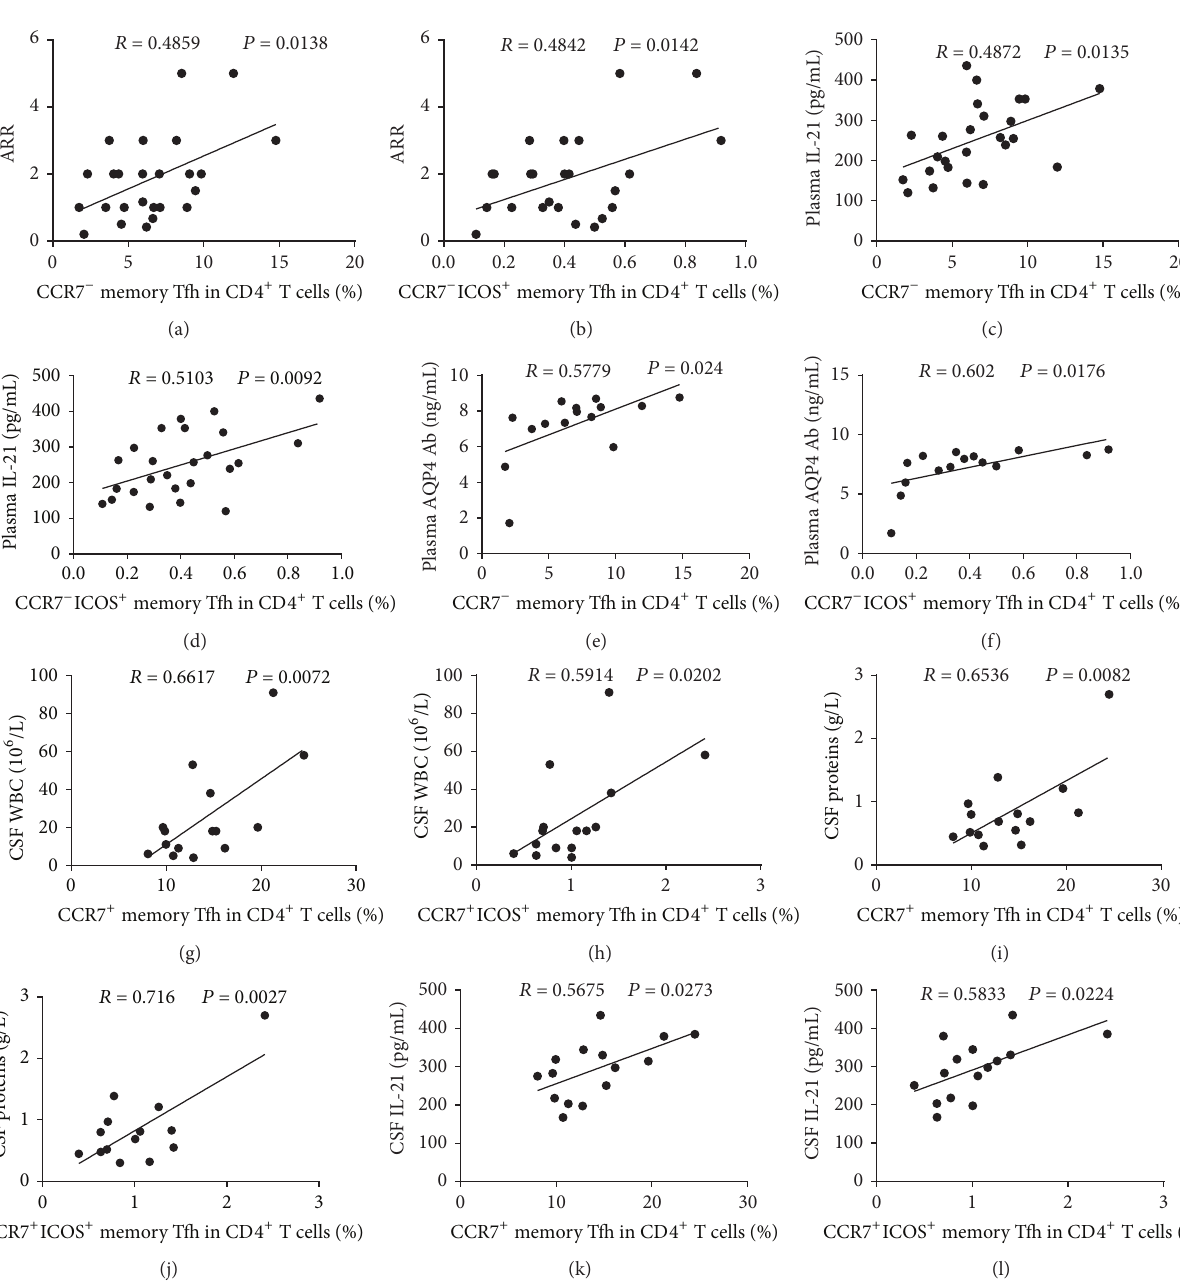
Figure 6: Correlation analysis of different subsets of circulating memory Tfh cells with the values of clinical measures in NMO/NMOSD patients. ((a)-(b)) The percentages of CCR7 − and CCR7 − ICOS + memory Tfh cells were positively associated with the ARR in NMO/NMOSD patients. ((c)-(d)) The percentages of CCR7 − and CCR7 − ICOS + memory Tfh cells were positively associated with the levels of plasma IL- 21. ((e)-(f)) The percentages of CCR7 − and CCR7 − ICOS + memory Tfh cells were positively associated with the levels of plasma AQP4 Ab in AQP4 Ab-seropositive patients. ((g)-(h)) The percentages of CCR7 + and CCR7 + ICOS + memory Tfh cells were positively correlated with CSF WBC counts. ((i)-(j)) The percentages of CCR7 + and CCR7 + ICOS + memory Tfh cells were positively correlated with the levels of CSF proteins. ((k)-(l)) The percentages of CCR7 + and CCR7 + ICOS + memory Tfh cells were positively correlated with the levels of CSF